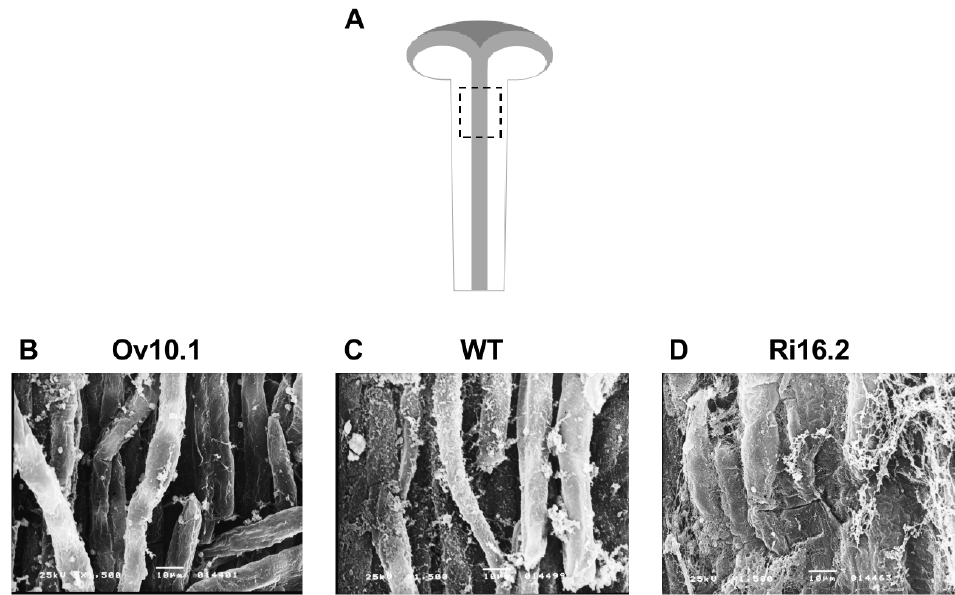
Figure 6. Scanning electron microscopy (SEM) of stage 11 stylar transmitting tissue of wild type (SR1) and transgenic plants.( A ) Drawing of stigma/style, the dotted line box indicates the portion analyzed by SEM. ( B ) SEM of the STT from line Ov10.1 transgenic plant overexpressing NtPAE1 . ( C ) SEM of the STT from a wild type plant. ( D ) SEM of the STT from line Ri16.2 transgenic plant silencing NtPAE1 . The images highlight the differences in the cell-cell adhesion on the first one-third of the stylar transmitting tissue of transgenic plants in relation to the wild type plant (1500× magnification). Bar = 10